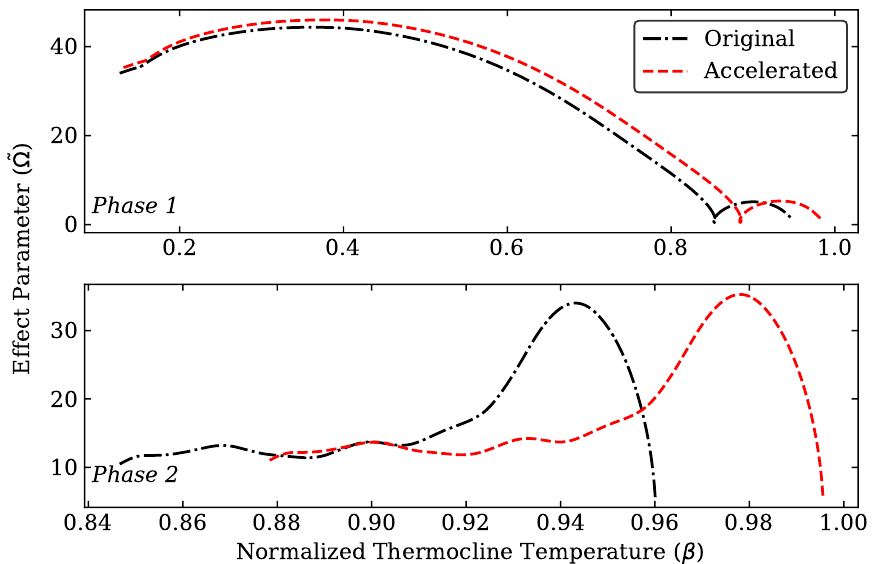
Figure 13. Scaled process curves of charging mode at the inlet